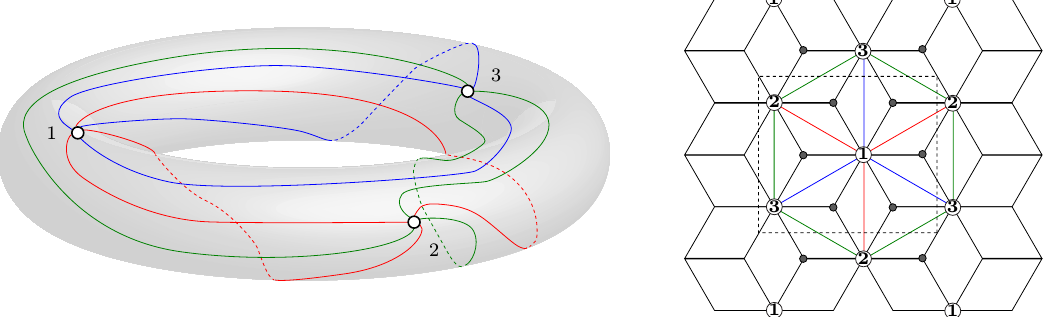
; ‘ ( (cid:26) ) ; ‘ ( (cid:26) ) with 12 23 31